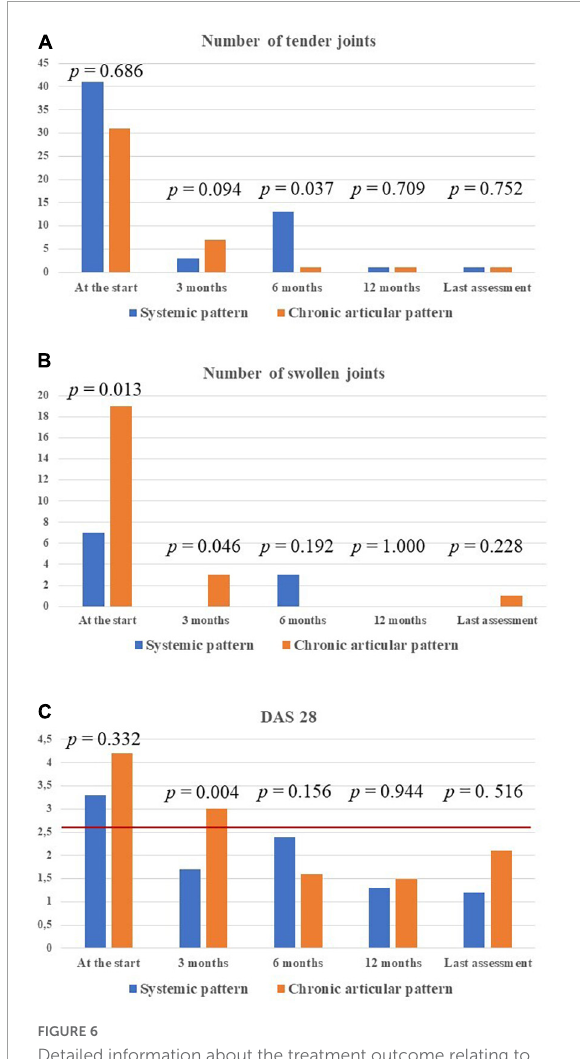
FIGURE6 Detailed information about the treatment outcome relating to joints involvement among the 14 patients with arthritis. In particular, the total number of tender joints (A) and swollen joints (B) in all patients enrolled, distinguished according with Still’s disease course, has been provided. The DAS28 values have also been detailed in the two types of Still’s disease (C) . P -values refer to the differences between the two subgroups of patients in the number of tender joints, swollen joints and DAS28 values at each time-point. The red horizontal line in panel (C) indicates the DAS28 threshold below which arthritis may be considered in remission. DAS28, disease activity score based on 28